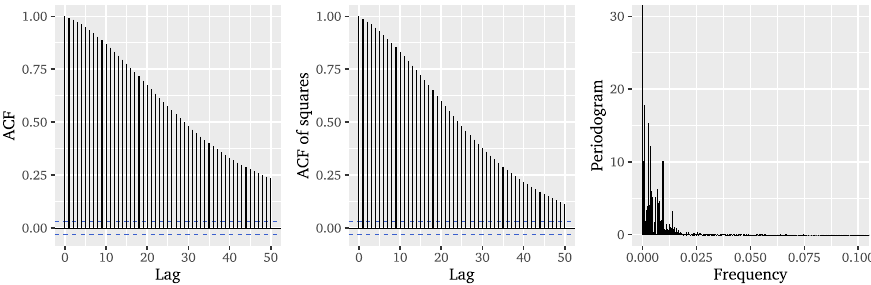
Figure 2. Autocorrelation functions and periodogram of the significant wave heights. Thus, the visual inspection of the considered dataset implies that the dependence structure of the significant wave heights exhibits both short- and long-term